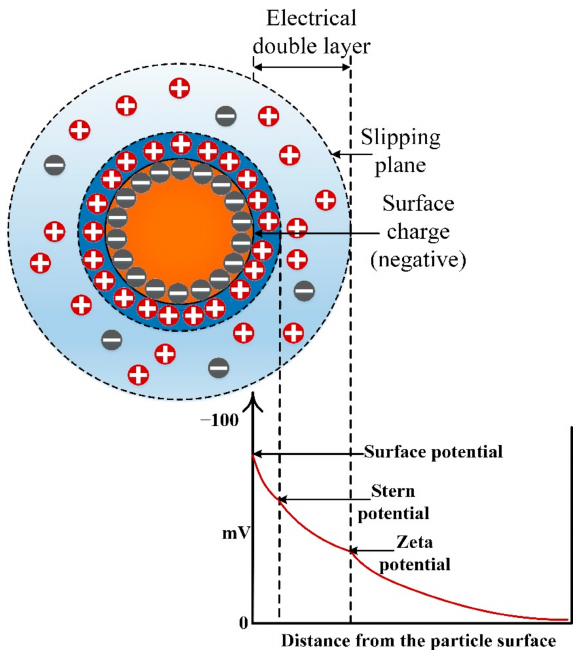
Figure 2. Schematic illustration of electrical double layer and zeta potential.